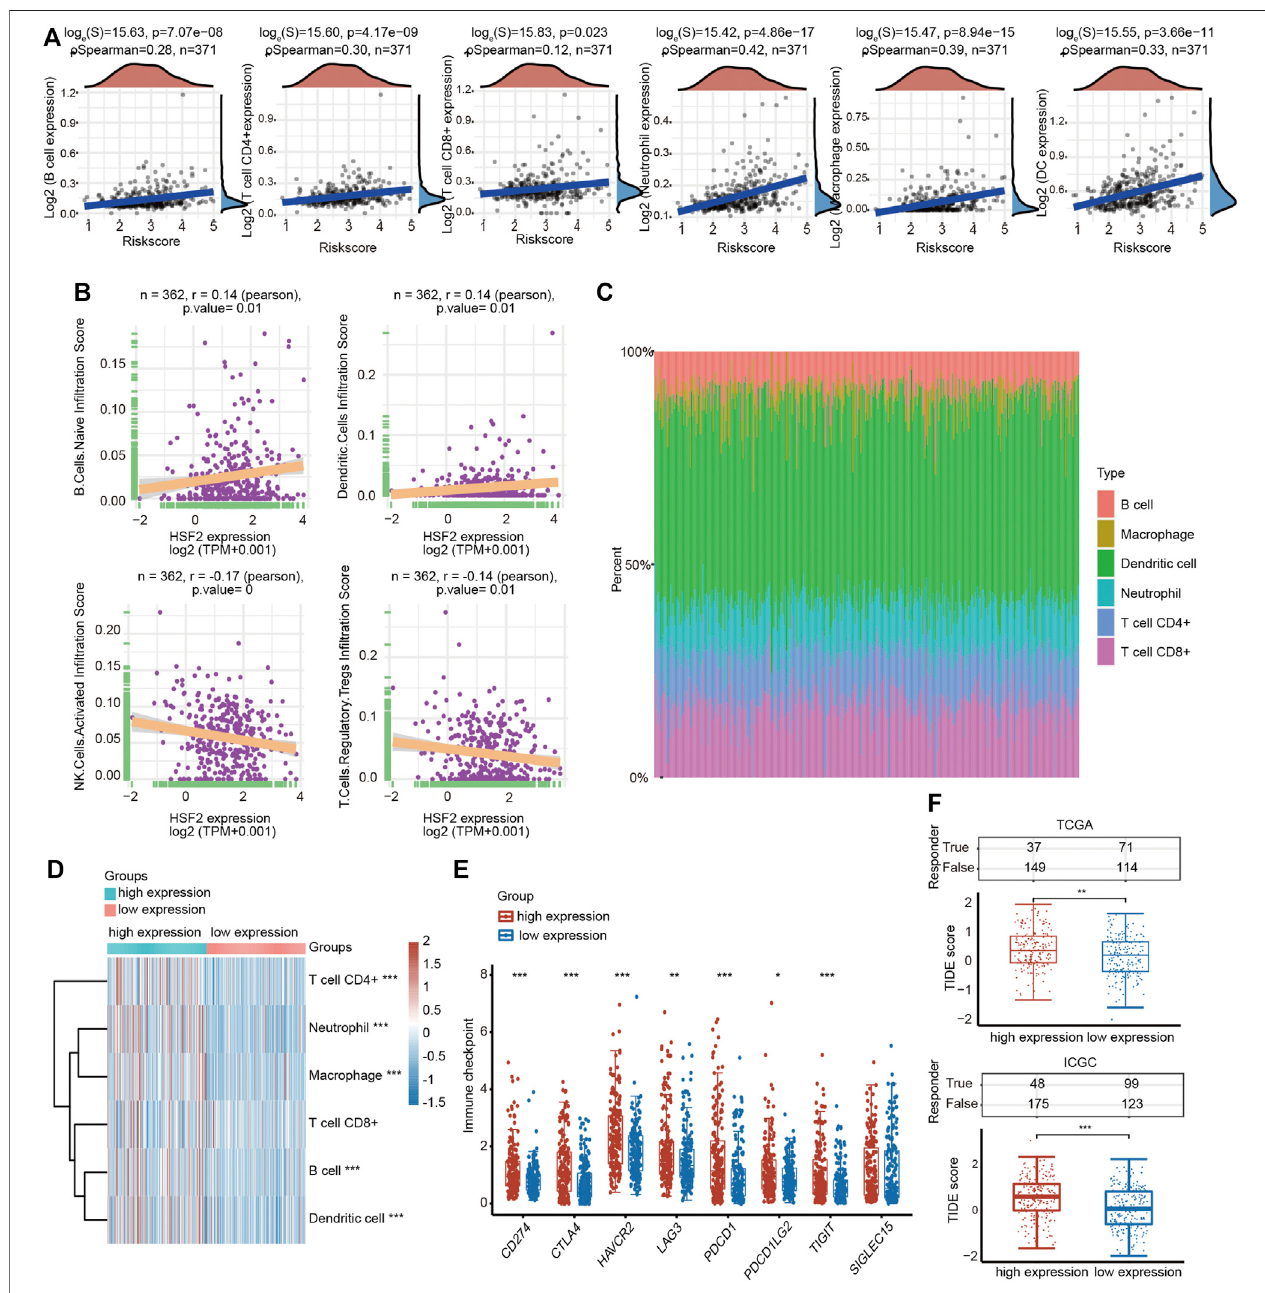
FIGURE 8 | Relationship between HSF2 expression and in fi ltration levels of immune cells in HCC. (A) HSF2 expression was signi fi cantly and positively associated withthein fi ltration levels ofB cells, CD8 + Tcells, CD4 + Tcells, macrophages, neutrophils and dendriticcellsin HCC accordingtothe TIMER databaseanalysisusing the R software package ggstatsplot ( n (cid:1) 371). (B) HSF2 expression was positively or negatively correlated with the in fi ltration of different immune cells in HCC according to theCIBERSORTalgorithm. (C) Visualizationofthein fi ltratinglevelsofdifferentimmunecellsintheHCCsamples. (D) Comparisonoftheproportionsofimmunecells in the HSF2 high-expression and low-expression groups. (E) The expression of multiple immune checkpoint genes between the HSF2 low-expression group and the high-expression group. These results were obtained using the R software (v4.0.3) package ggplot2 and pheatmap. (F) The TIDE score between the HSF2 low- expression group and the high-expression group based on TCGA and ICGC databases. * p < 0.05, ** p < 0.01, *** p < 0.01.